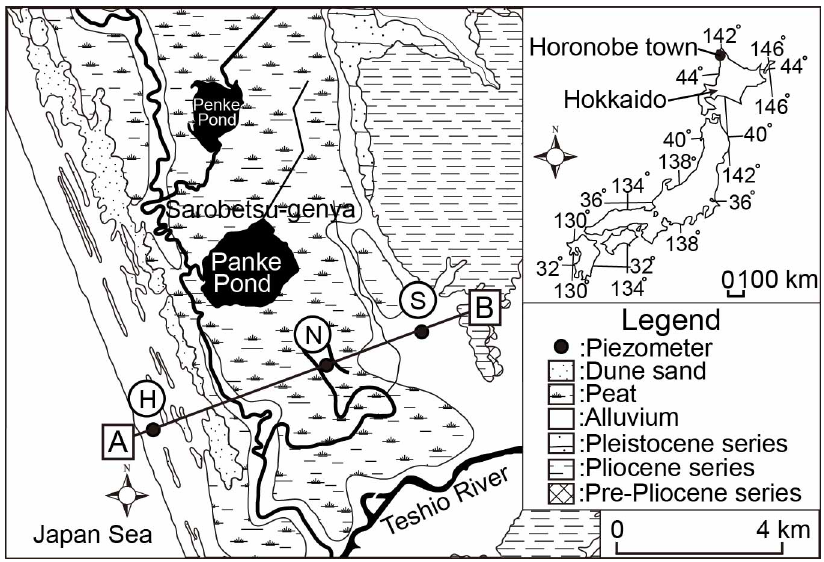
Figure 1. Study area, location of piezometers, and geological map (data from [18]). The A–B line is a topographical transect shown in Figure